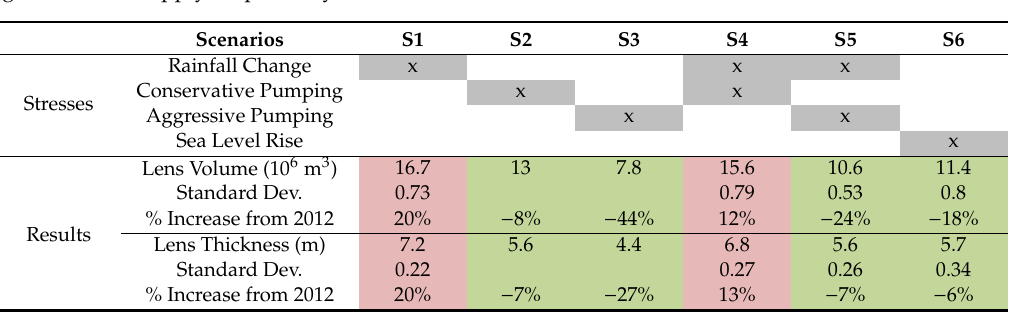
Table 1. Summary of the six model scenarios and statistics of the resulting simulated lens thickness (m) and lens volume (106 m 3 ) in the year 2050. The grey cells with “x” are the scenarios that include the stresses. The rose and green shades indicate scenarios that result in an increase and decrease in groundwater supply,